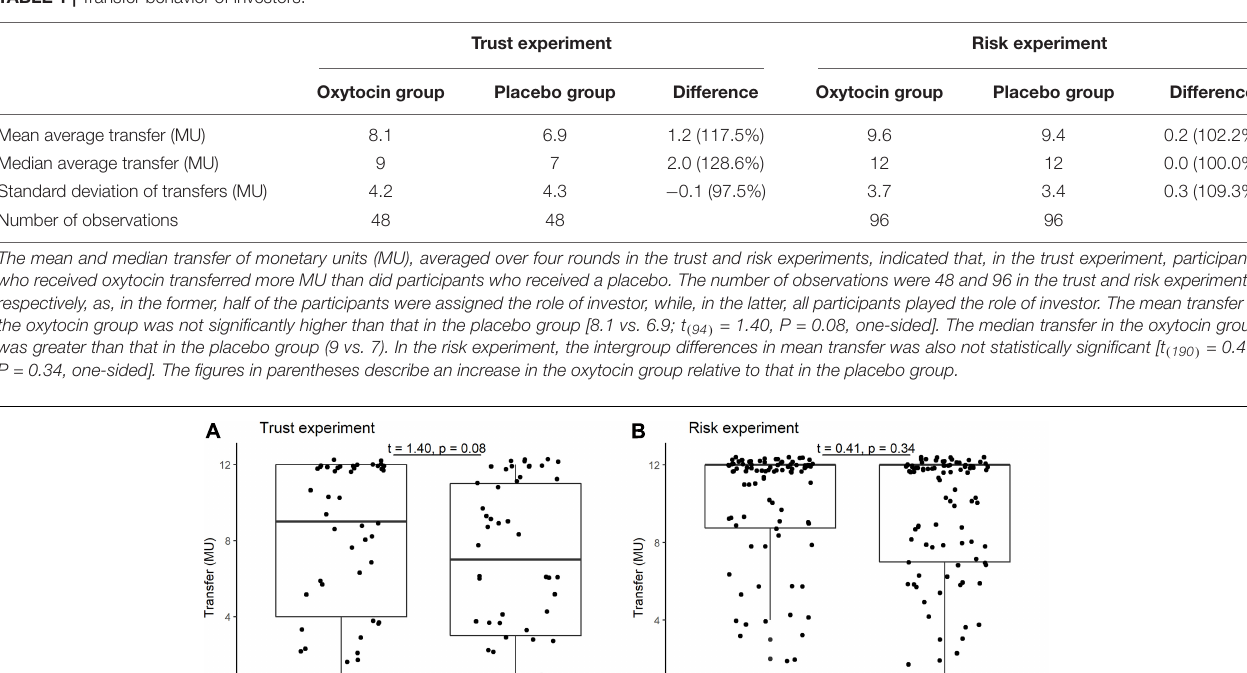
TABLE 1 | Transfer behavior of